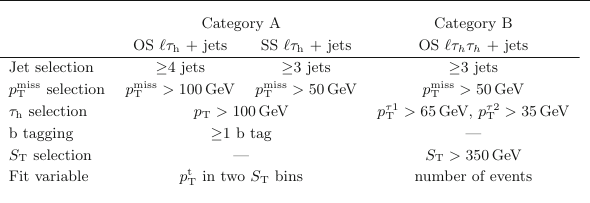
Table 1 Summary of selection criteria in event categories A ( (cid:5)τ h + jets) and B ( (cid:5)τ h τ h + jets), where (cid:5) = μ, e. In category A, the two subcategories, OS and SS, are defined by the charge of the (cid:5)τ h pair. The fit variable used in each category is also